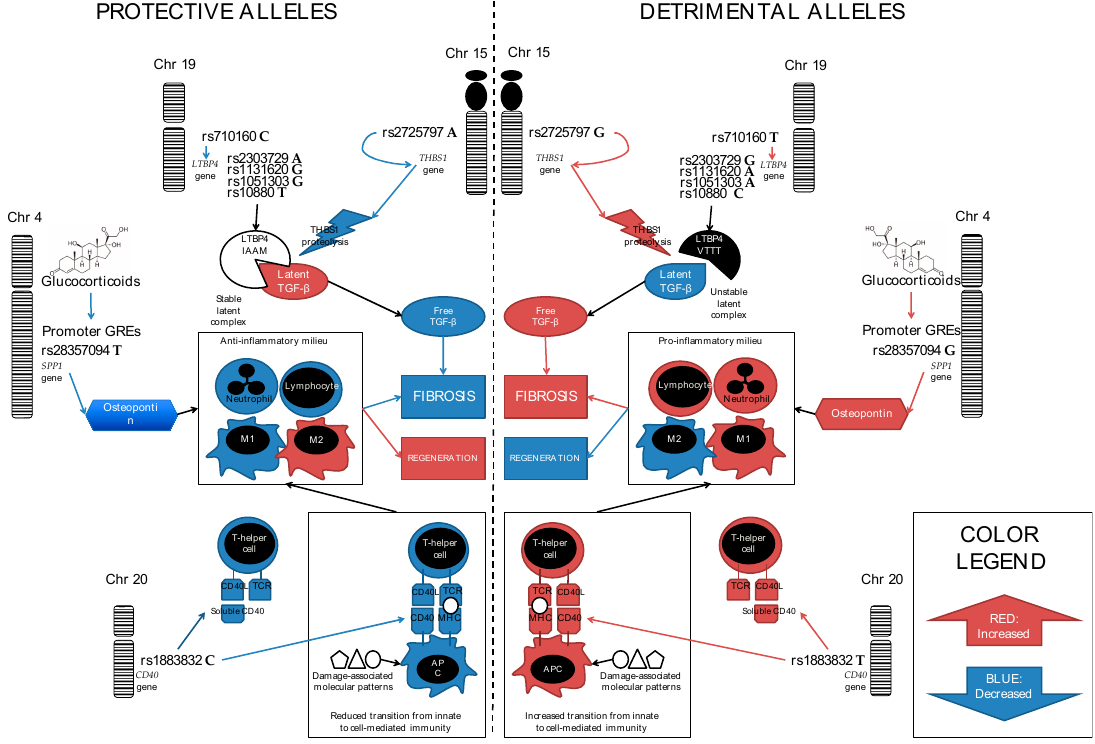
Figure 1. Diagram of the molecular mechanisms proposed to explain the associations of modifier single nucleotide polymorphisms (SNPs) with Duchenne muscular dystrophy (DMD) phenotypes. The color blue indicates molecules, pathways, or biological processes that are reduced in association with a certain genotype; while the color red indicates those that are increased. On the left hand side are represented protective alleles of the modifier SNPs, and their consequences; while the right hand side specularly represents detrimental alleles. Note that only genes with mechanisms related to fibrosis and inflammation are represented here. ACTN3 , which modifies DMD through different mechanisms related to the sarcomere and muscle fiber type, is excluded.